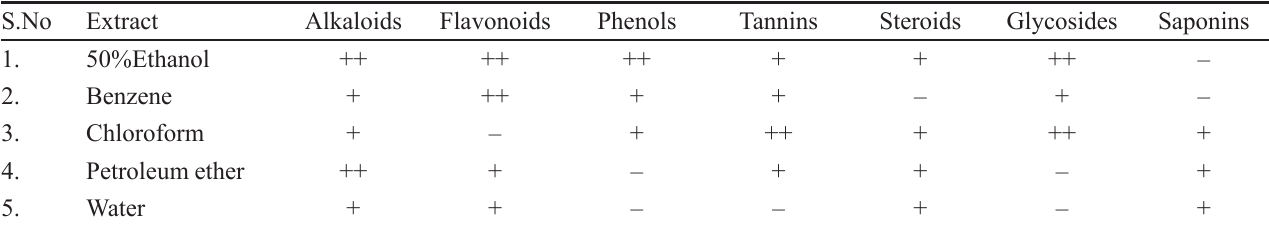
TABLE I - Phytochemical screening of white Nelumbo nucifera flowers in different solvent extracts S.No Extract